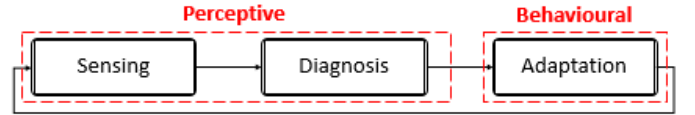
Figure 1. A closed-loop process of adaptive sampling consisting of three segments: perception, diagnosis and adaptation.